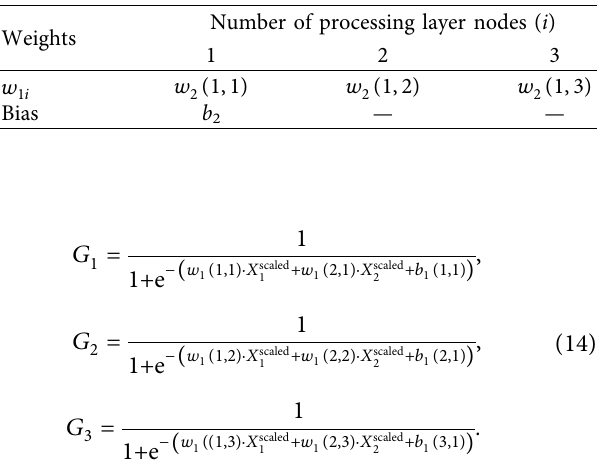
Table 2: Weight values between output and processing